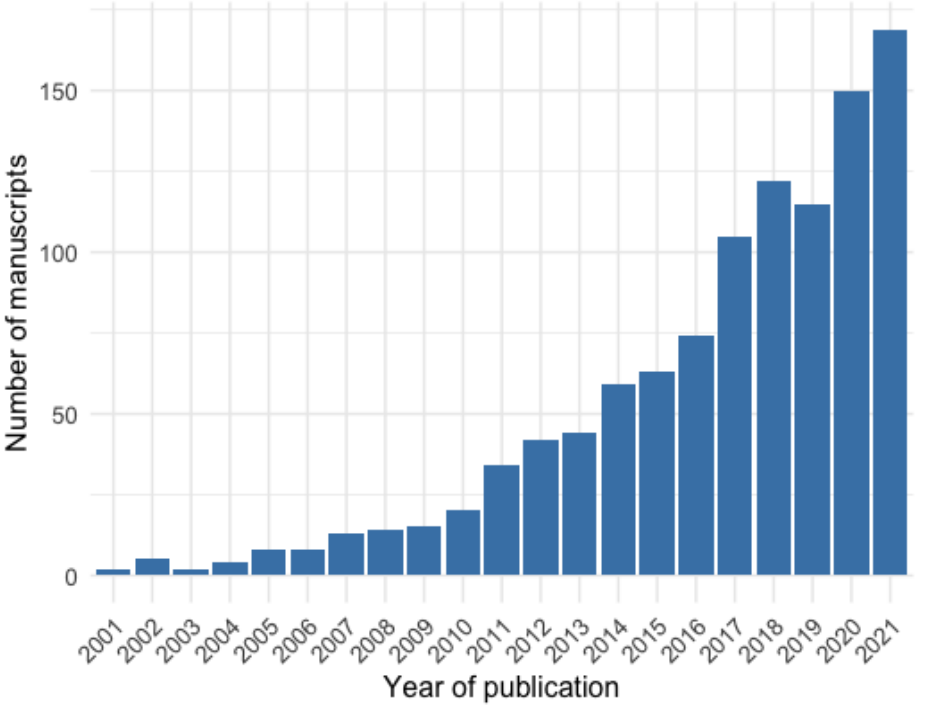
Figure 2. Publication trend from January 2001 to October 2021. Table 2. Study inclusion and exclusion